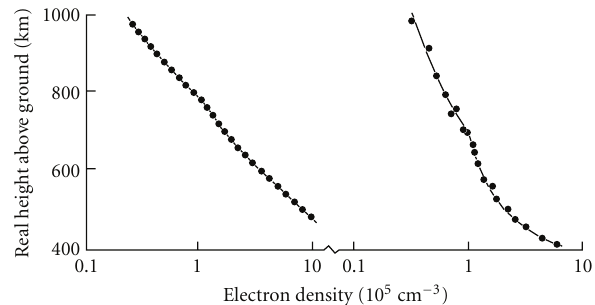
Figure 5: Electron density distributions showing the field-aligned ledge (from King et al. [19]). Both the topside sounder and inco- herent backscatter techniques show the same phenomenon. Left, Al- ouette-1 satellite data over Singapore, revolution 290, 15th profile. Right, Jicamarca, Peru, ISR data 24 April 1962, 06:10 EST.